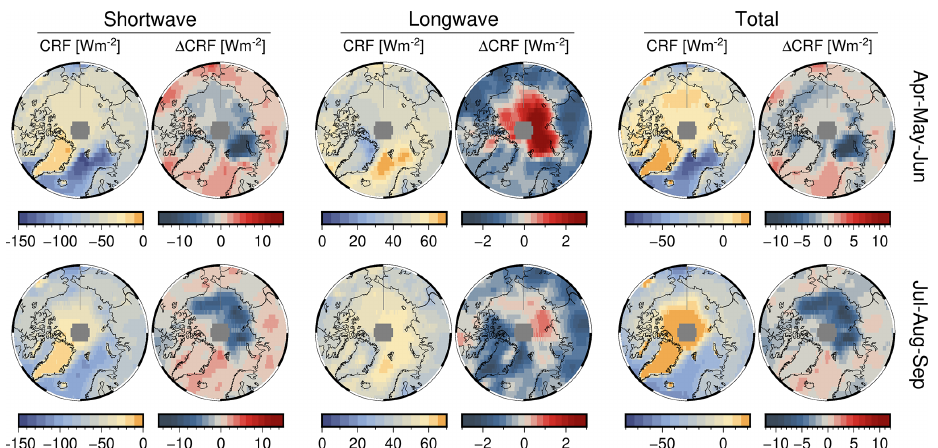
Figure 11. For Arctic spring (AMJ, top) and summer (JAS, bottom), the multiyear mean cloud radiative forcing (CRF) and total change (cid:49) CRF at the surface. None of the trends within the 2 decades of the record is statistically significant at 95% confidence. The time of trend emergence (ToE) for each spectral interval is plotted in Fig. D1, and the first year of seasonal ToE is reported in Tables 2 and 3 for the 12 Arctic regions of this study. Table 2. For Arctic spring (AMJ), the pan-Arctic and regional climatological mean (1996–2016) of cloud radiative forcing (CRF in Wm − 2 ) at the surface (BOA, bottom of atmosphere) and total trend (Wm − 2 over 20 years) with 1 standard deviation. In parentheses, the time of emergence (in years) for the CRF trends to become statistically significant at 95%